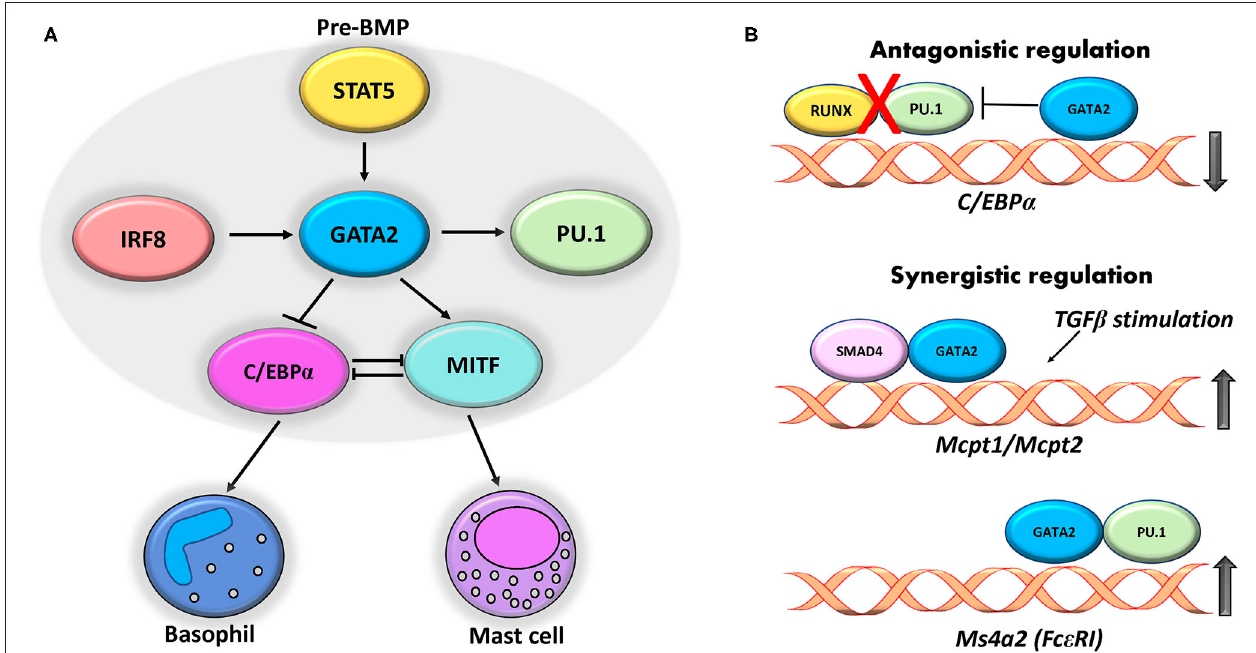
FIGURE 1 | Cross regulatory interplay between transcription factors. (A) GATA2 expression in pre-BMPs is induced by STAT5 that in turn regulates expression of C/EBP and MITF that give rise to basophil and mast cells. IRF8 and PU.1 act synergistically with GATA2 to regulate the expression of mast cell genes. (B) GATA2 binds to + 37kb region on C/EBP α gene and ablates binding of RUNX1 and PU.1 thereby repressing its expression. Cooperative regulation of GATA2 with SMAD4 and PU.1 induces expression of mast cell protease (Mcpt1 and 2) and Ms4a2 respectively in mast cells.